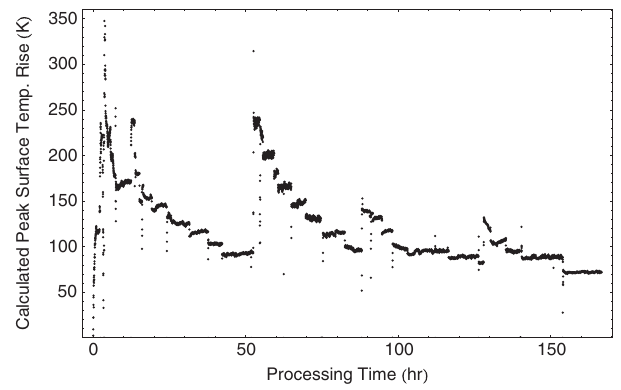
FIG. 10. Calculated peak surface temperature rise due to pulsed heating in the PBG-R structure. Note the excursions to over 200 K early in the